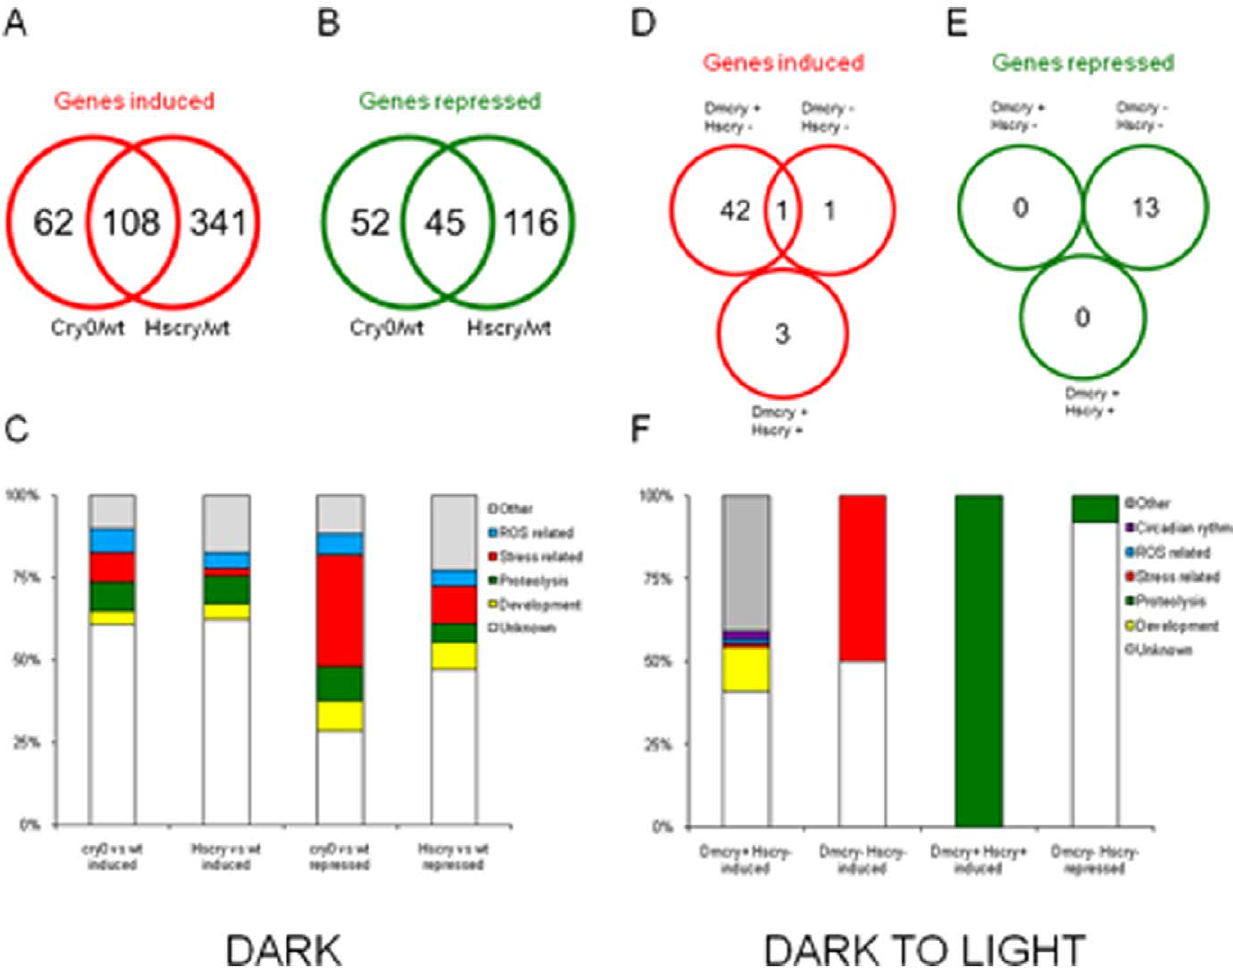
Figure 3. Transcriptome analysis of cryptochrome dependent gene expression in developing pupa one day after third instar larval stage. A, B Venn diagram of genes either upregulated (red) or downregulated (green) in the indicated strains under conditions of complete darkness. Comparison were performed in triplicate biological samples and analysed for statistically different expression patterns according to established programming techniques (see methods). C. Graphical representation of categories of genes either repressed or activated by cryptochromes in the indicated comparisons. All comparisons are for strains maintained in complete darkness (DD) from the time of egg laying. D,E. Venn diagrams of genes up-regulated or down-regulated in the indicated strains (wt, cry 0 , or Hscry1 transgenics) after transition from dark to two hours blue light at